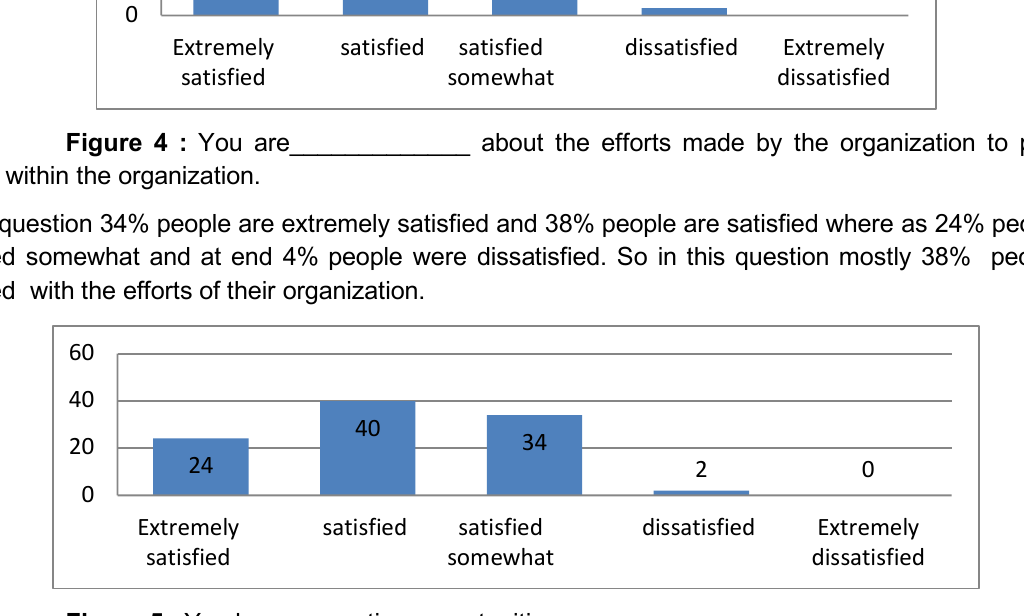
Figure 5 : You have promotion opportunities.